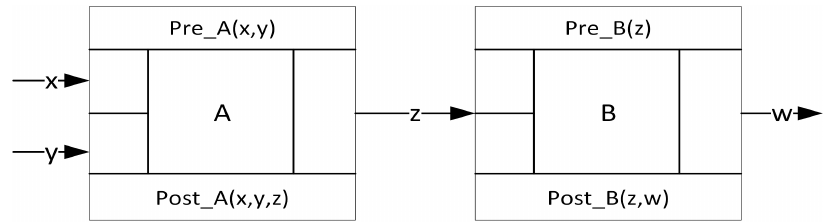
Figure 1. The process A and process